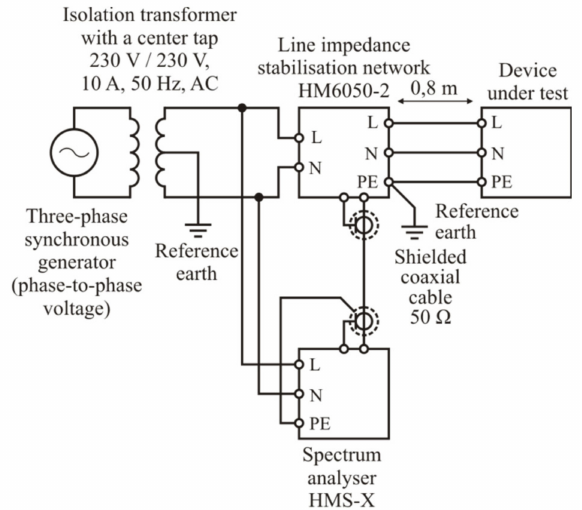
Figure 3. Simplified schematic diagram of a test circuit used for measuring the conducted interference in the 148-kHz–30-MHz frequency band. Our system includes a three-phase generator, in which we used phase-to-phase voltage. It is connected to an isolation transformer with a grounded